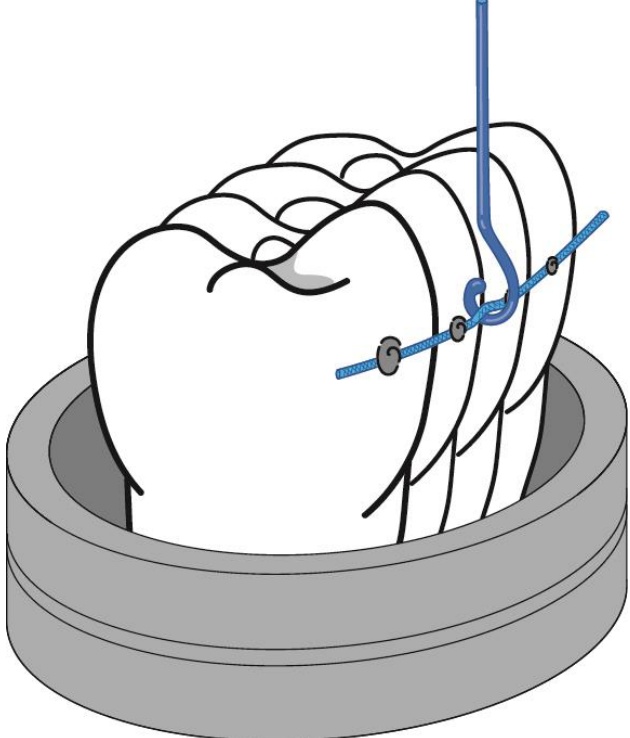
Figure 2. Scheme of mechanical tests.